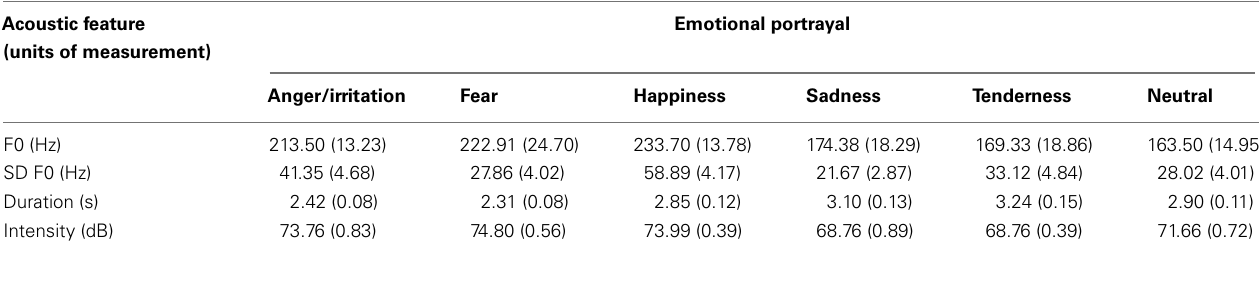
Table 1 | Means associated with the acoustic features of the Macquarie battery of emotional prosody (standard errors are shown in